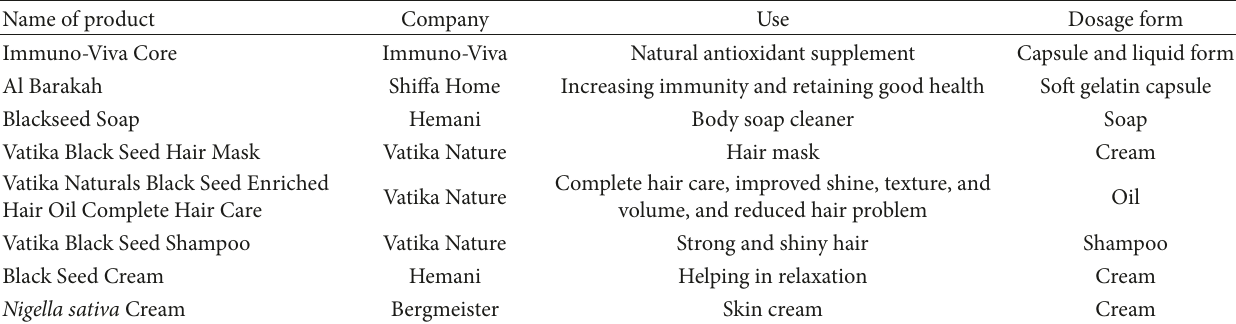
Table 3: Some commercial products containing Nigella sativa